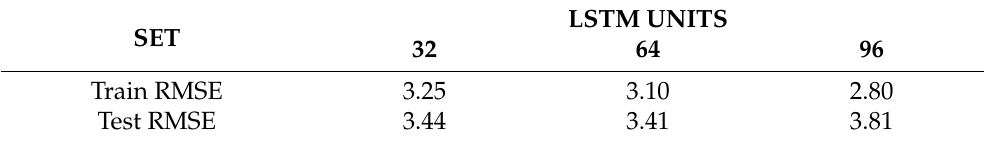
Table 5. Average RMSE for LSTM model with attention mechanisms against LSTM unit